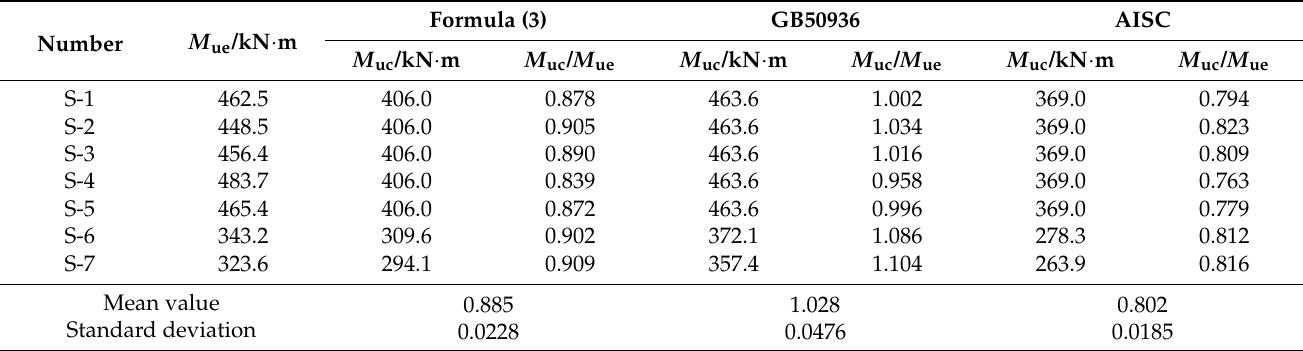
Table 5. Comparisons of the test value and calculated value of the moment capacity of each